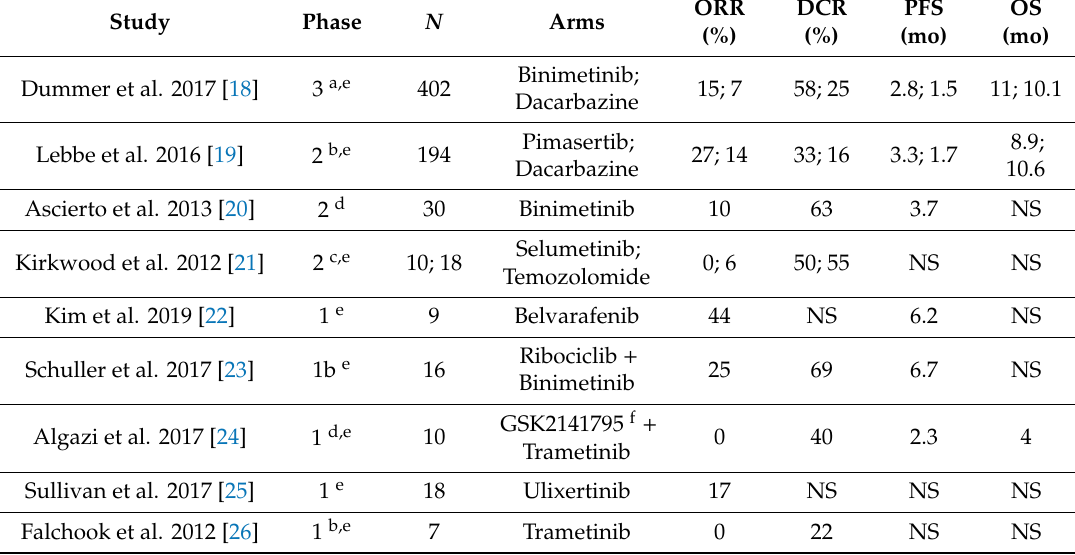
Table 1. Selected NRAS-mutant melanoma clinical